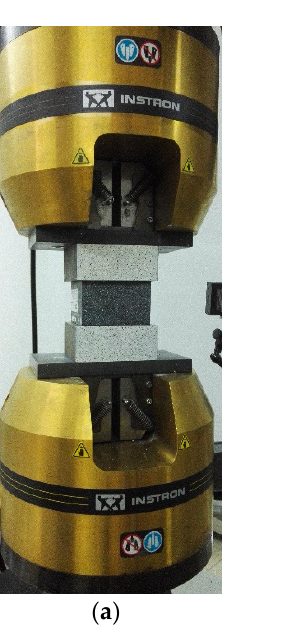
Figure 5. The elastomeric bearings placed in the testing machine ( a ) high bearing, ( b ) low bearing.